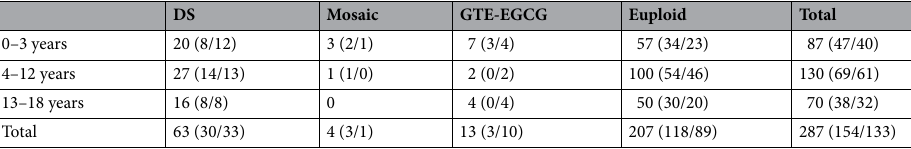
Table 2. Human cohort by age group. Total number of children as well as separated numbers by gender (Female/Male) are provided. As sexual dimorphism may affect facial shape, we assessed facial differences between males and females by computing the Procrustes distances among gender groups and a permutation test (10,000 rounds) in each age category. 0–3 years old group: Sexual dimorphism was not a significant factor ( P (0–3) = 0.4965), and results did not differ when genders were analysed by separated (Figs. S3 and S4). 4–12 years old group: sexual dimorphism was not significant ( P (4–12) = 0.1470). However, as the sample size of the GTE-EGCG treated cases was limited, results are presented as “Supplementary Information” (Fig. S8). 13–18 years old group: despite sexual dimorphism was significant ( P (13–18) = 0.0138), we pooled male and female samples after checking that gender was not the main source of variation in the sample (Fig. S5) and that results separated by gender were consistent with the results from the pooled analyses (Fig. S6). In this group, we could not assess whether the treatment had a differential gender effect, as all the GTE-EGCG treated children were